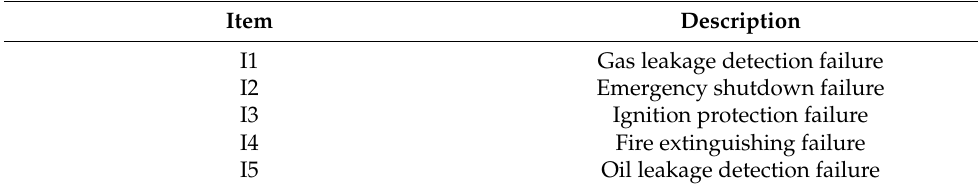
Table 4. Control and mitigation barriers description of